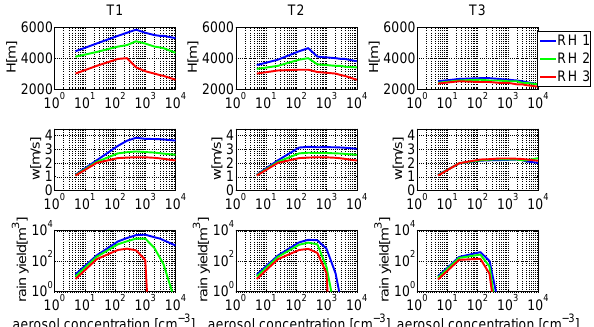
Figure 7. The cloud’s maximum top height (top panels), the maxi- mum over time of the mean vertical velocity weighted by the mass in each grid point (middle panels) and the total surface rain yield (bottom panels) as a function of the aerosol loading, for each sim- ulated cloud as a function of the aerosol concentration. Each curve represents 10 simulations performed for an initialization profile (a total of nine